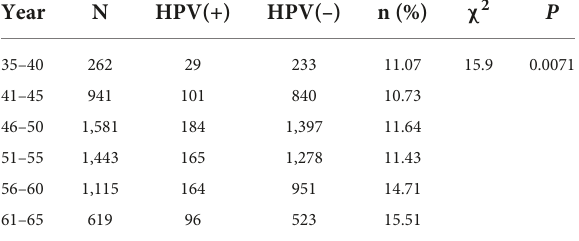
TABLE 10 Age specificity of human papillomavirus (HPV)